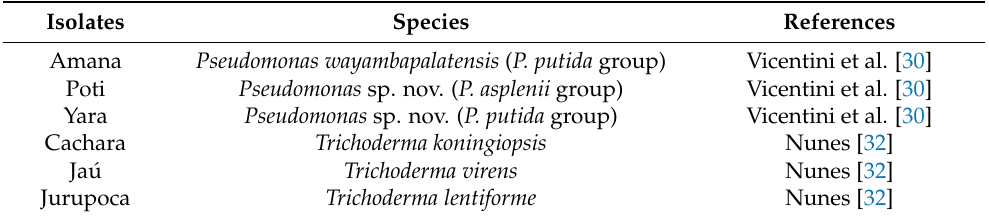
Table 1. Fluorescent Pseudomonas bacteria and fungal antagonists from the genus Trichoderma used in this